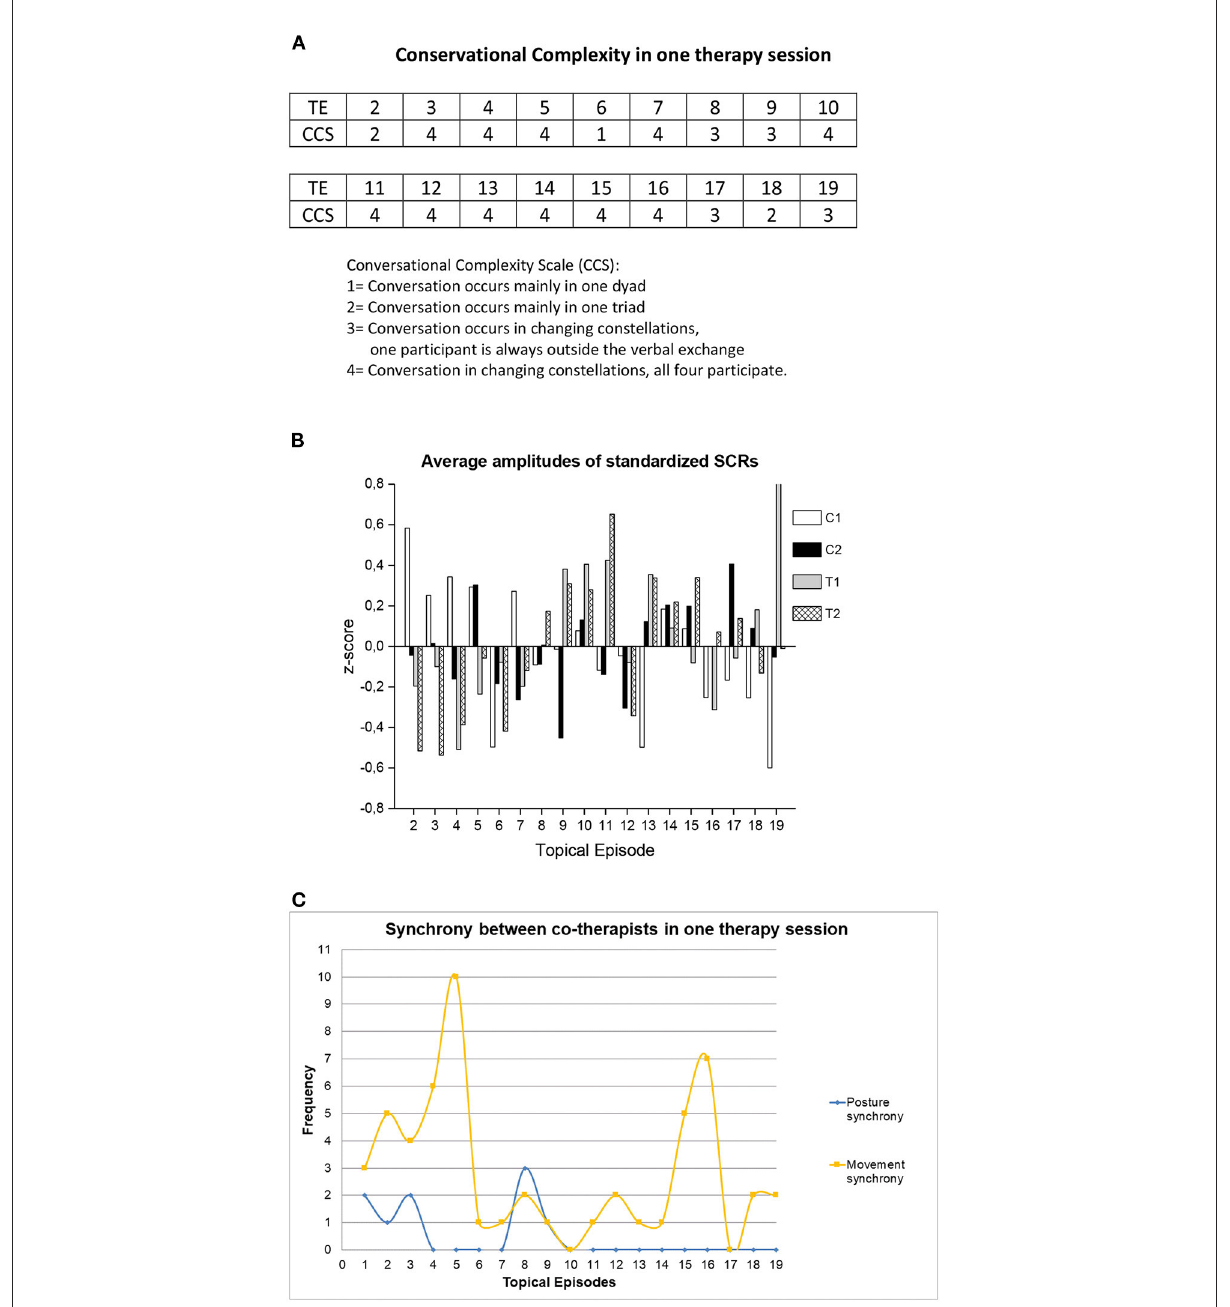
FIGURE1 Visualizations of different variables from one couple therapy session. (A) For each topical episode (TE) Conversational complexity (CCS) was observed and rated. (B) The average arousal levels as standardized Skin Conductance Responses (SCRs); measured = represented = indexed for each topical episode. C1 = client 1, C2 = client 2, T1 = therapist 1, T2 = therapist 2. The panel (B) has previously been published in (45). (C) The frequency of the co-therapists’ posture and movement synchrony per topical episode. (A) presents coding of Conversational Complexity for shorter thematic segments (Topical Episodes), and (B,C) visualize the embodied variables per topical episode.